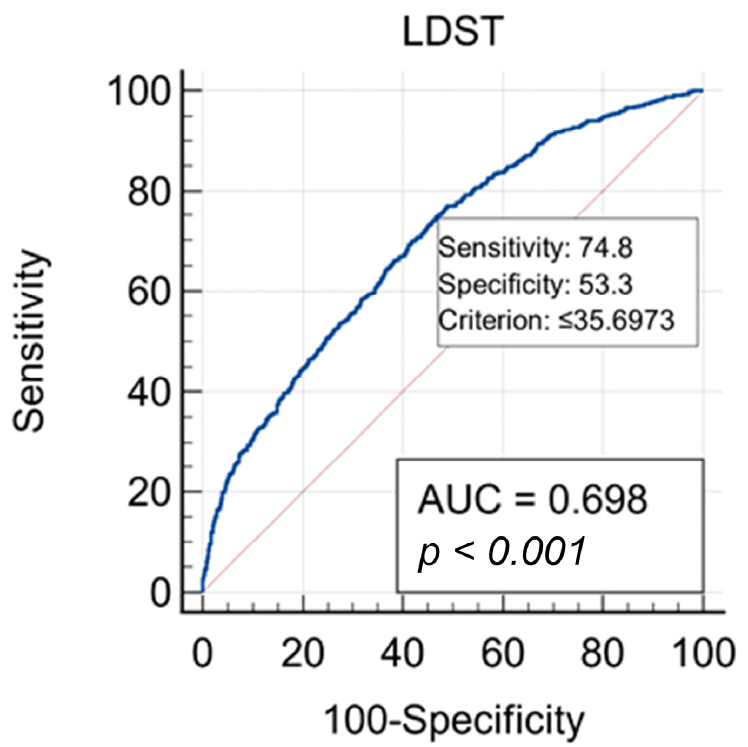
Figure 3. ROC curve of LDST.